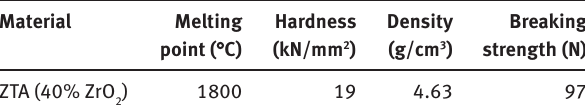
Table 2: Physical and mechanical properties of the ceramic particles. Material